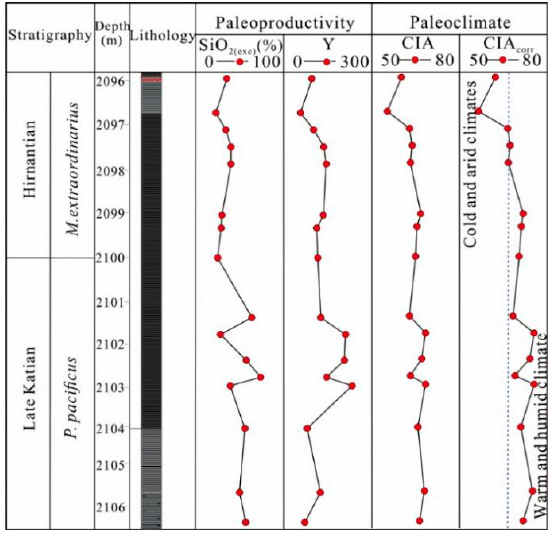
Figure 4. Profiles of Y, SiO 2(exc) and chemical index of alteration (CIA) values from the well ZY5. Vertical dashed lines show the approximate ranges between cold or arid climate conditions, and warm and humid climate conditions. Lithological legend and abbreviations as in Figure